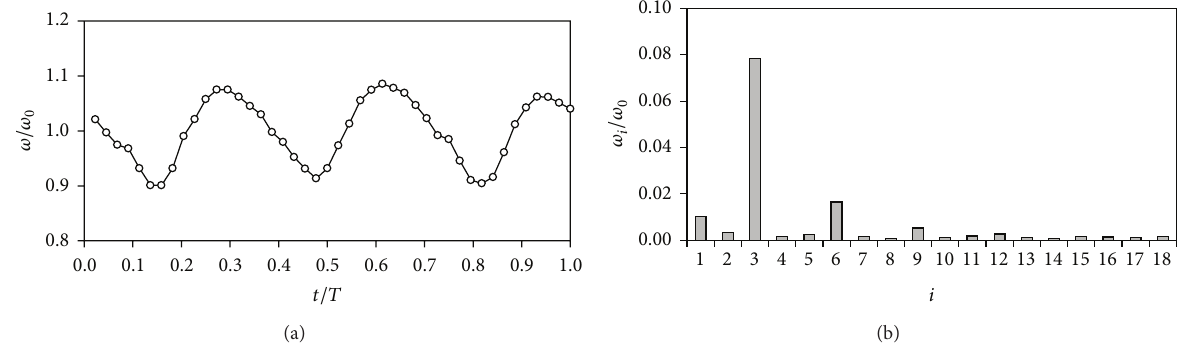
Figure 1: Relative-to-the-average rotational speed, 𝜔/𝜔 0 , of a Thies 4.3303 anemometer during one turn at 8m/s wind speed [47] (a) and non- dimensional values of the Fourier series decomposition performed on that rotational speed, 𝜔 𝑖 /𝜔 0 (b). 𝑇 is the period of the anemometer’s rotation.